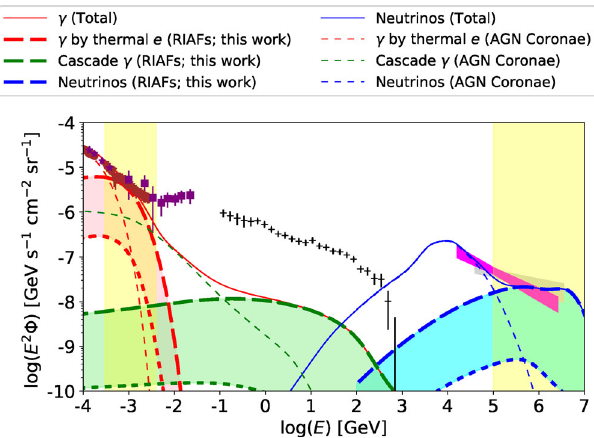
Fig. 3 Gamma-ray and all- fl avor neutrino background intensities. Data points are provided by Swift BAT 115 (brown-circle; 1- σ errors for systematic and statistical errors), SMM 116 (brown-triangle; de fi nition of errors are not available), Nagoya-baloon 117 (purple-star; de fi nition of errors are not available), COMPTEL 2 (purple-square; 2- σ error bars for the linear sum of the systematic and statistical errors), Fermi LAT 3 (black-plus; 1- σ errors with systematic and statistical uncertainties), and IceCube 4,118 (lightgrey and magenta regions; 68% con fi dence levels). The red, blue, and green lines indicate background intensities for photons by thermal electrons, neutrinos by CR protons, and gamma-rays by proton-induced electromagnetic cascades, respectively. The thick, thin-dotted, and thin- solid lines are contributions from RIAFs in LLAGN (this work), coronae in luminous AGN 23 , and sum of these, respectively. Thick-dashed and thick- dotted lines are drawn with the luminosity functions of Ref. 45 and Ref. 53 , respectively, and the regions between the two lines are fi lled with the corresponding colors. The yellow vertical bands represent the energy bands where LLAGN provide the dominant contribution. The Fermi data should be reproduced by another source class, such as radio-loud AGN 7,52,114